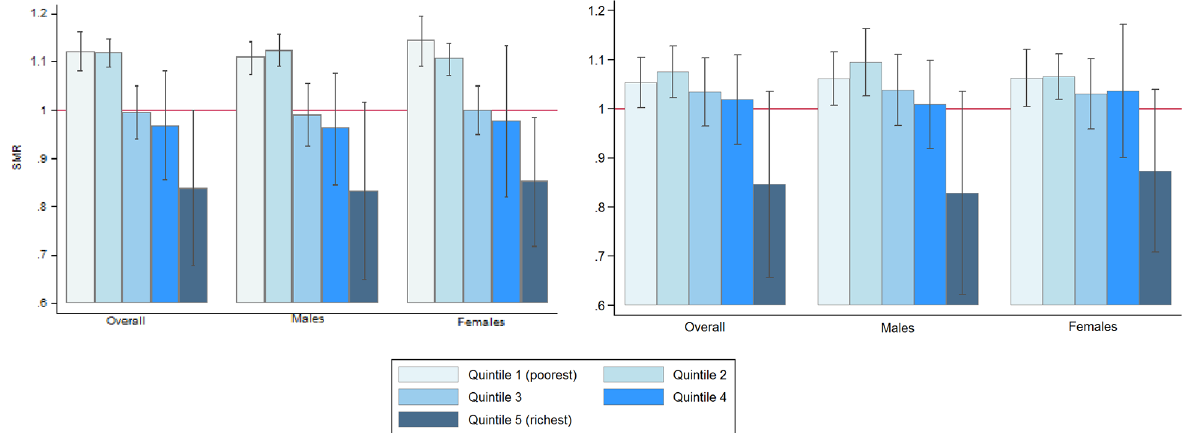
Fig 2. Age-gender adjusted SMRs and age-gender-ethnicity adjusted SMRs for each quintile by overall population, males and females in Peninsular Malaysia. The reference line at y = 1 indicates the SMR of the standard population, which is of Peninsular